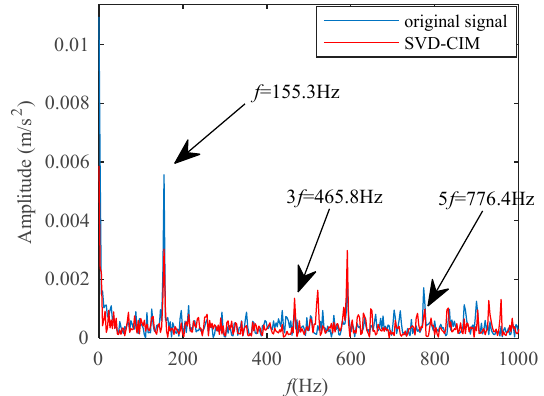
Figure 18. CCES of two-channel signals.